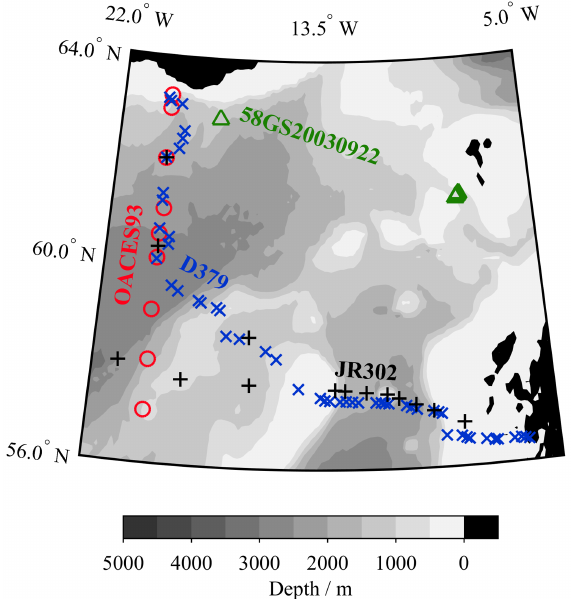
Figure 9. Map of JR302 and historical sampling stations used in the cross-over analysis (Table 2). There were no stations suitable for cross-over analysis outside of the area shown on this map. Black plusses show JR302, blue crosses are D379, green triangles are 58GS20030922, and red circles are OACES93. Only historical sta- tions within 150km of a JR302 station were used, as described in Sect.